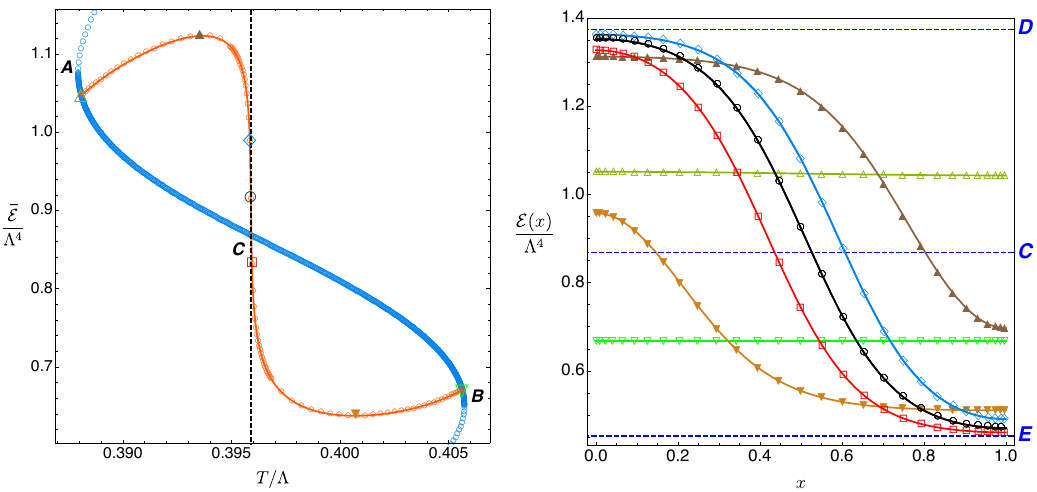
Figure 13 . Lumpy branes at constant ˆ L ’ 11 . 501849 . (Left) ˆ E as a function of ˆ T . This figure repro- duces figure 11 but this time it singles out only the relevant lumpy brane with ˆ L = ˆ L ’ 11 . 501849 (cid:13) (orange circles) and the uniform branes (blue circles) and zooms in on the relevant region. It also identifies 7 solutions whose energy density profiles are then plotted on the right panel. From left to right these are given by: ( ˆ T, ˆ E ) 4 ’ (0 . 388085 , 1 . 047078) , ( ˆ T, ˆ E ) N ’ (0 . 393560 , 1 . 123216) , ( ˆ T, ˆ E ) (cid:5) ’ (0 . 395846 , 0 . 988820) , ( ˆ T, ˆ E ) ’ (0 . 3958945 , 0 . 914833) , ( ˆ T, ˆ E ) (cid:3) ’ (0 . 395941 , 0 . 831460) , (cid:13) ( ˆ T, ˆ E ) H ’ (0 . 400765 , 0 . 637410) , ( ˆ T, ˆ E ) O ’ (0 . 405648 , 0 . 667817) . (Right) Energy density profile ˆ E ( x ) for the 7 lumpy branes pinpointed in the left panel. 14 The same shape/colour code is